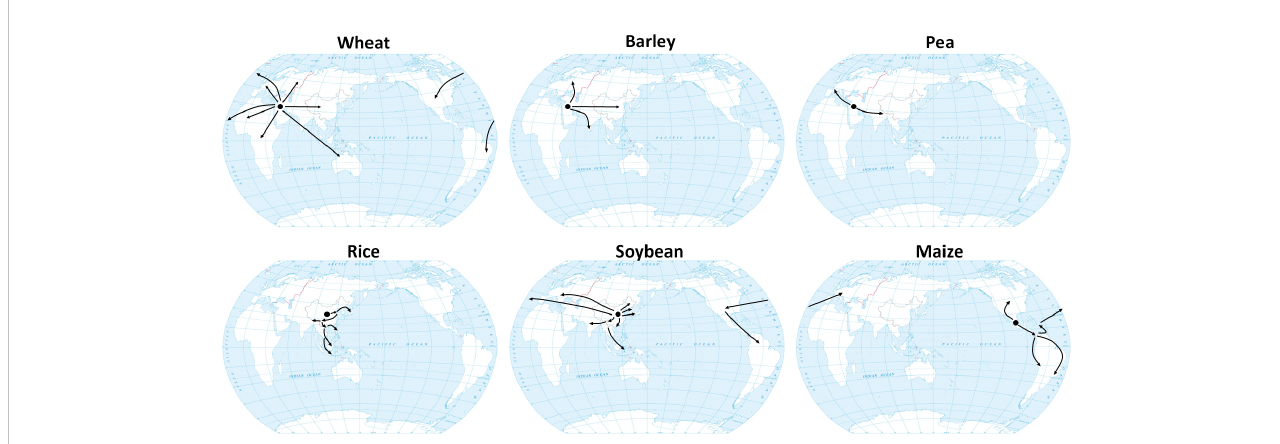
FIGURE 1 Domestication centers and hypothetical dissemination routes of major crops. Black arrows indicate the expansion scenario of wheat (Gohar et al., 2022), barley (Lister et al., 2018), pea (Jing et al., 2010), rice (Gutaker et al., 2020), soybean (Kihara, 1969; Hymowitz and Shurtleff, 2005; Stacey, 2008; Sedivy et al., 2017) and maize (Wang et al.,